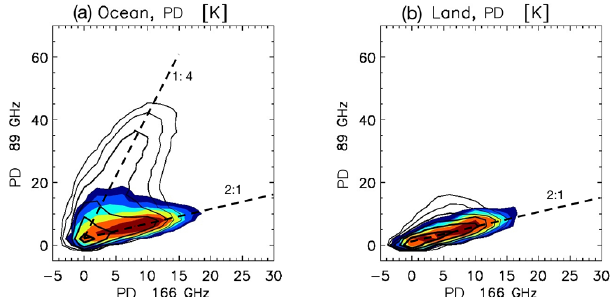
Figure 10. Joint PDF of 89 and 166GHz PDs during January 2015 over the (a) ocean and (b) land for precipitation with the bright band (color shaded) and without the bright band (black contours). Color and contours are normalized such that the total areas equal unity, and are plotted in log